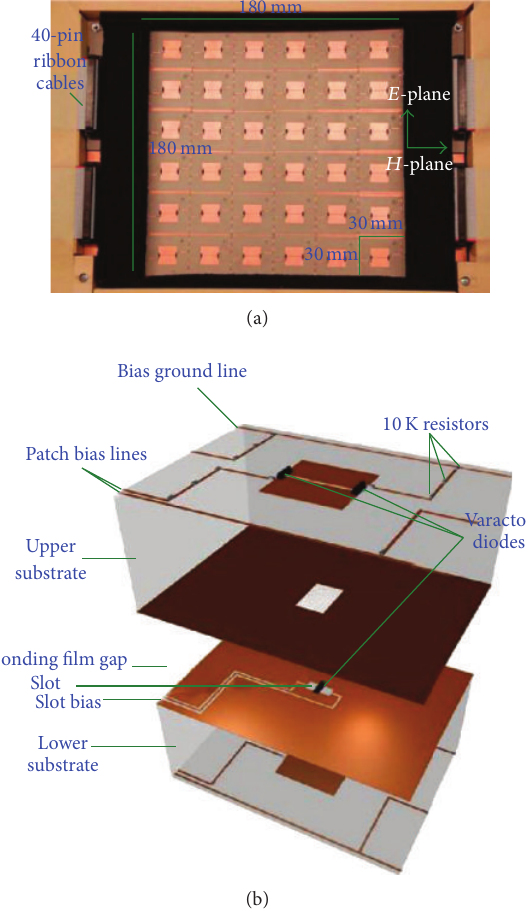
Figure 5: (a) Fabricated 6 × 6 planar reconfigurable array. (b) Array element and bias network design (vertically exaggerated) (with permission from IEEE).